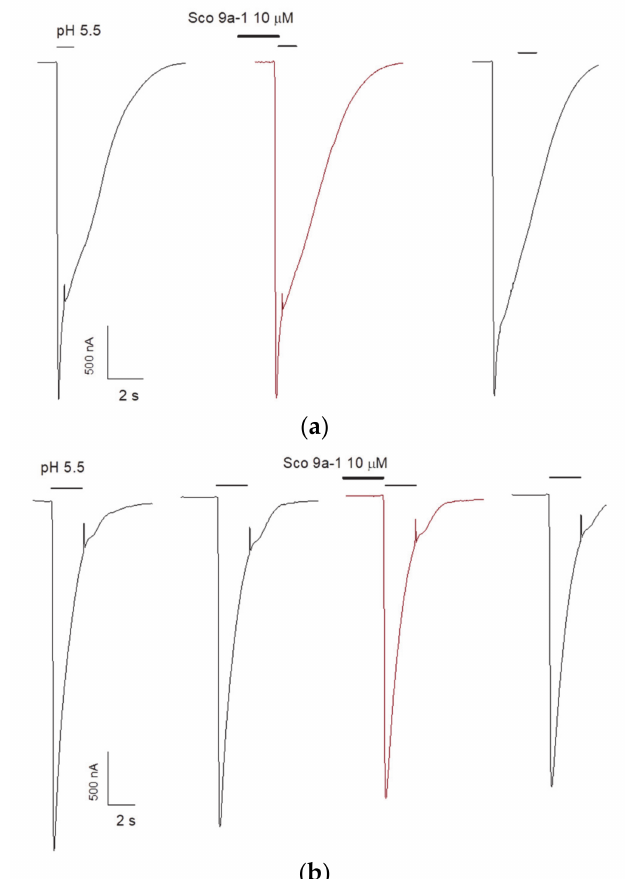
Figure 8. Acid-induced currents through rASIC1a ( a ) and rASIC3 ( b ) expressed in X. laevis oocytes were evoked by pH drop from 7.4 to